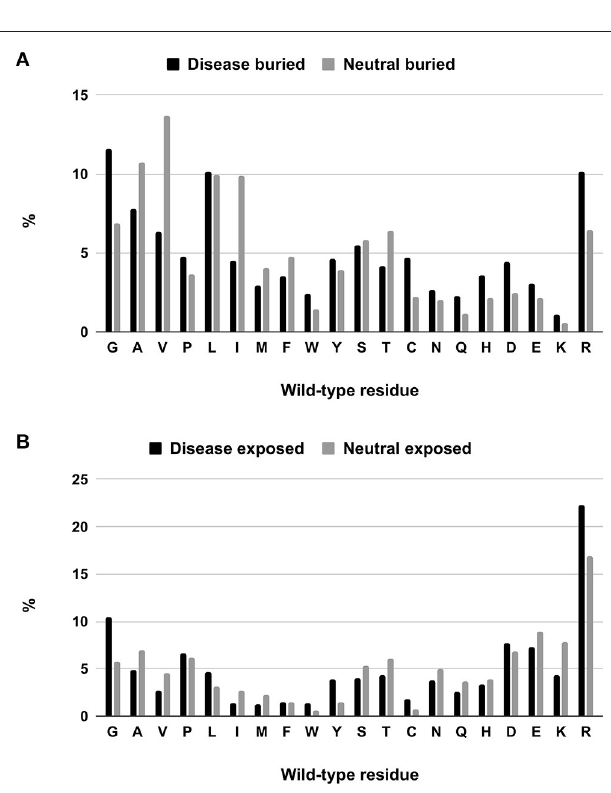
FIGURE 2 | Composition of buried (A) and exposed (B) wild-type residues undergoing disease-related and neutral variations in the HVAR3D-2.0 dataset.